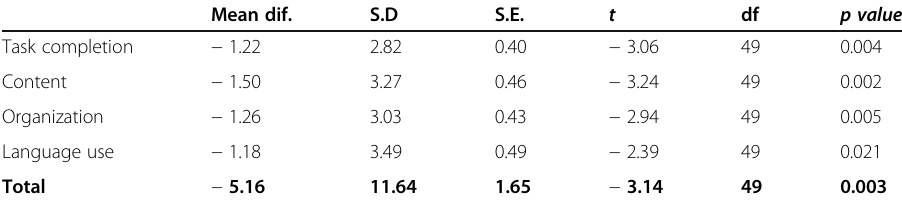
Table 3 Paired t test results: NRW vs. RW Mean dif.